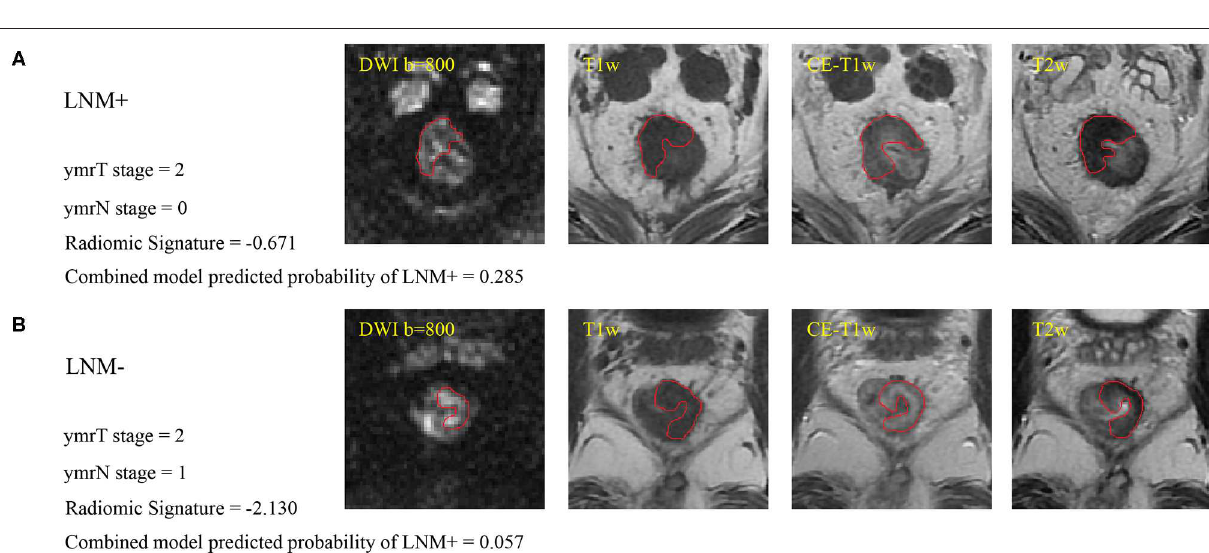
FIGURE 2 | (A) Sample images of LNM + , where the red line indicates the tumor margin. (B) Sample images of LNM–. Cutoffs for the radiomic signature and combined model are − 1.4208 and 0.0897, respectively, for patients with ymrT1-2 tumors in this study. These two patients were misdiagnosed by the radiologist but were correctly assessed by radiomics analysis. LNM + , lymph node metastasis; LNM–, lymph node non-metastasis; DWI, diffusion-weighted imaging; T1w, T1-weighted; CE-T1w, contrast-enhanced T1-weighted; T2w,